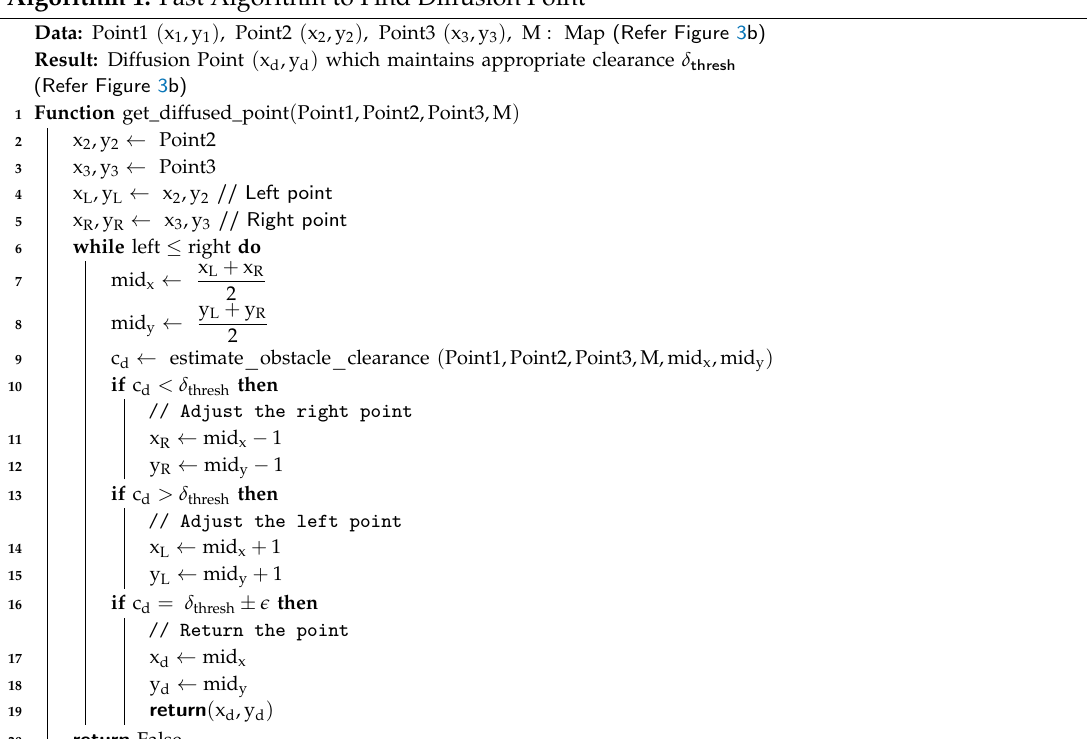
Algorithm 1: Fast Algorithm to Find Diffusion